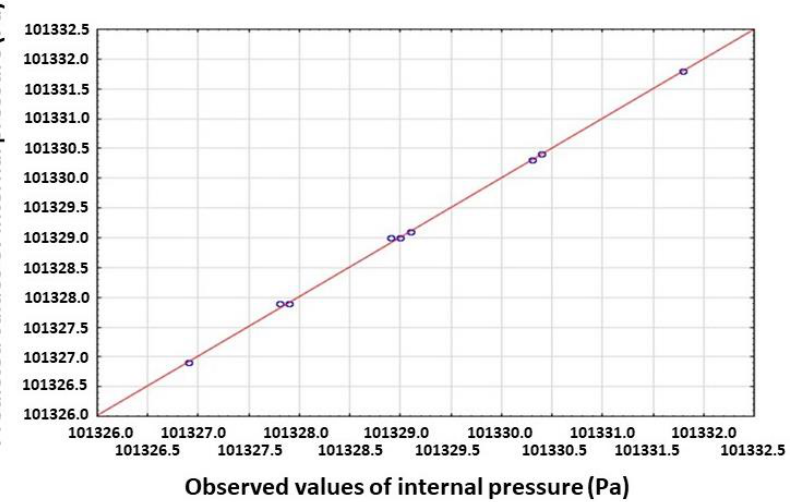
Figure 23. Predicted versus observed values of internal pressure in the reaction cell with upper air inlet and outlet geometry.